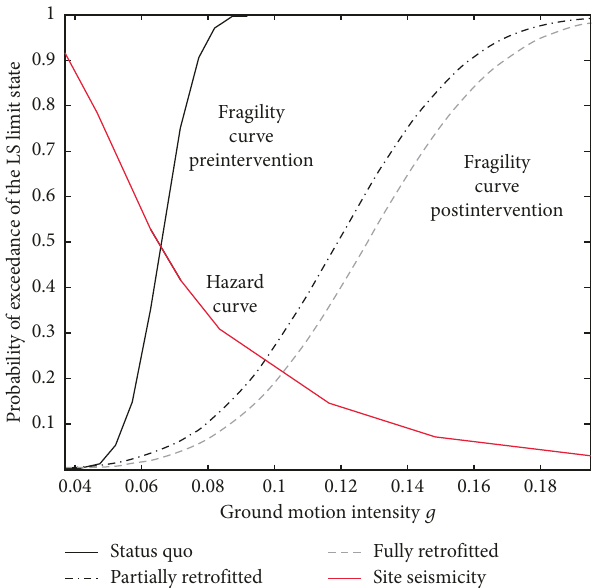
for the example building (no.